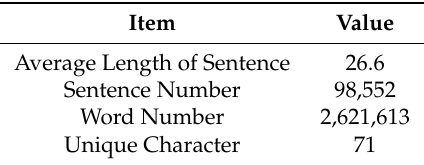
Table 3. The details of the Gutenberg corpus.